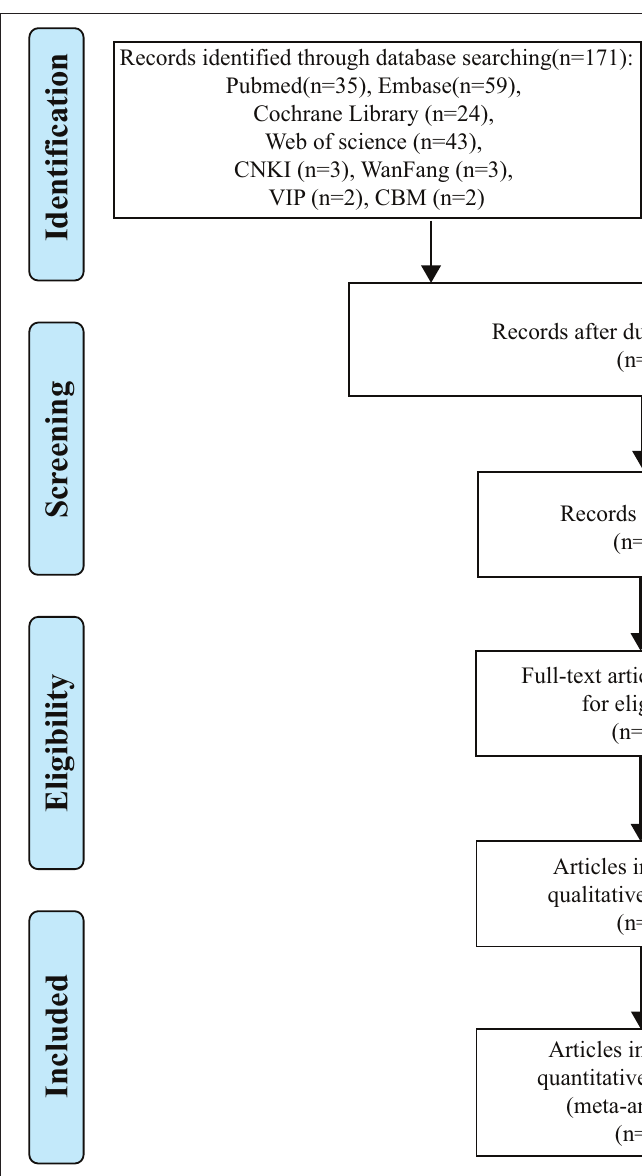
Frontiers in Pediatrics |